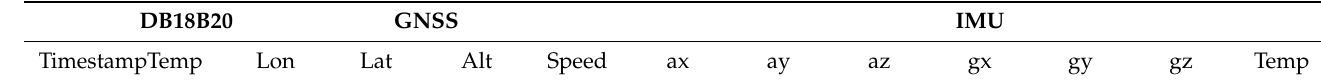
Table 3. Schema of raw data collected by the